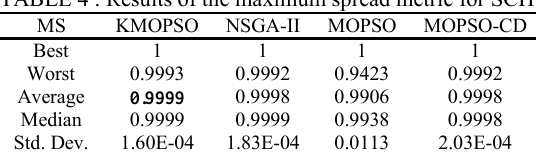
TABLE 4 . Results of the maximum spread metric for SCH.